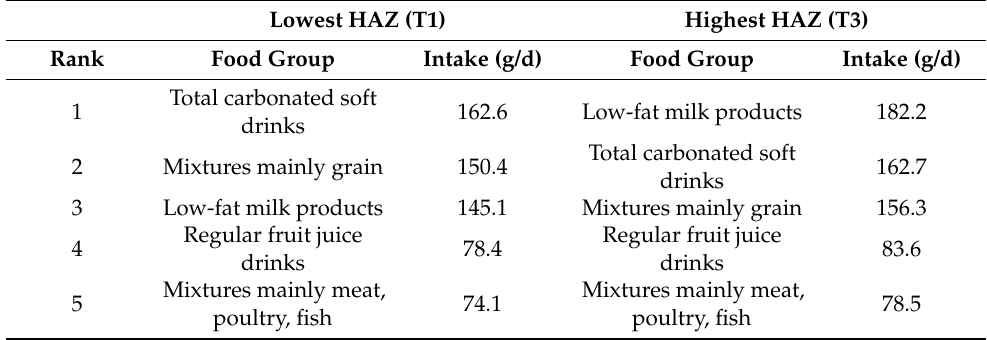
Table 4. Comparison of major foods consumed by children aged 2–18 years in the highest HAZ vs. lowest HAZ in NHANES 2007-2014 ( n =